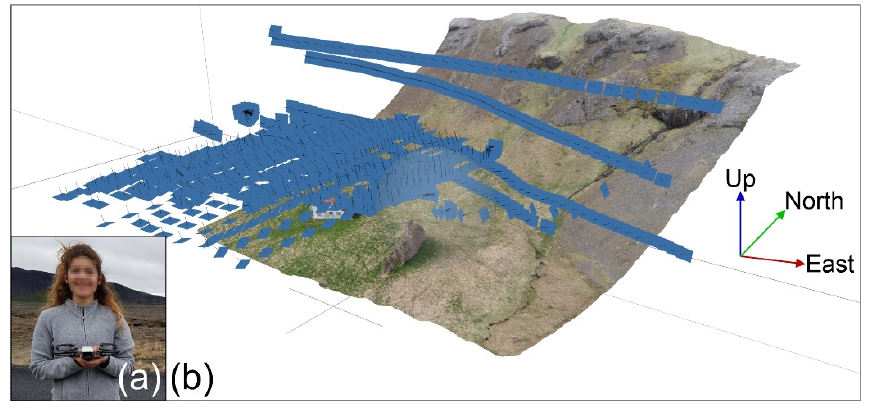
Figure 3. ( a ) The 0.300 kg unmanned aerial vehicle (UAV) used in the present work, equipped with propeller guards; person for scale. ( b ) Example of UAV-collected pictures with both nadir and oblique camera orientation.